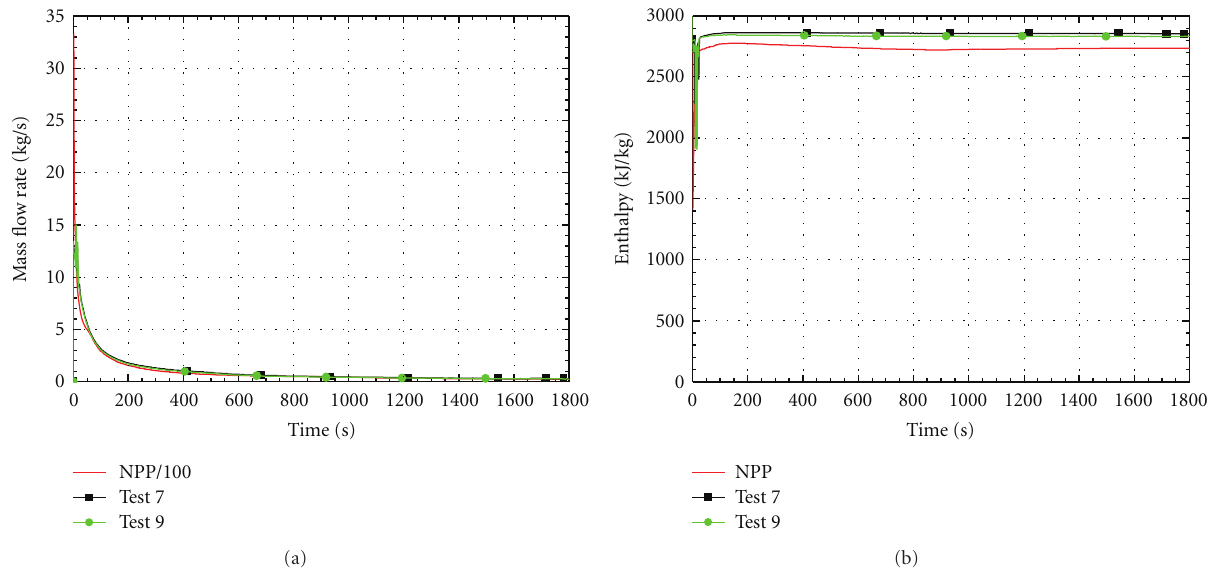
Figure 12: Comparison of experimental MERs with NPP scaled MER. Tests 7 and 9. (a) Break mass flow rate, (b) break enthalpy.